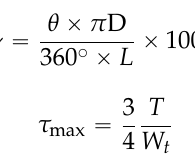
Table 1. Details of the monotonic test specimens.